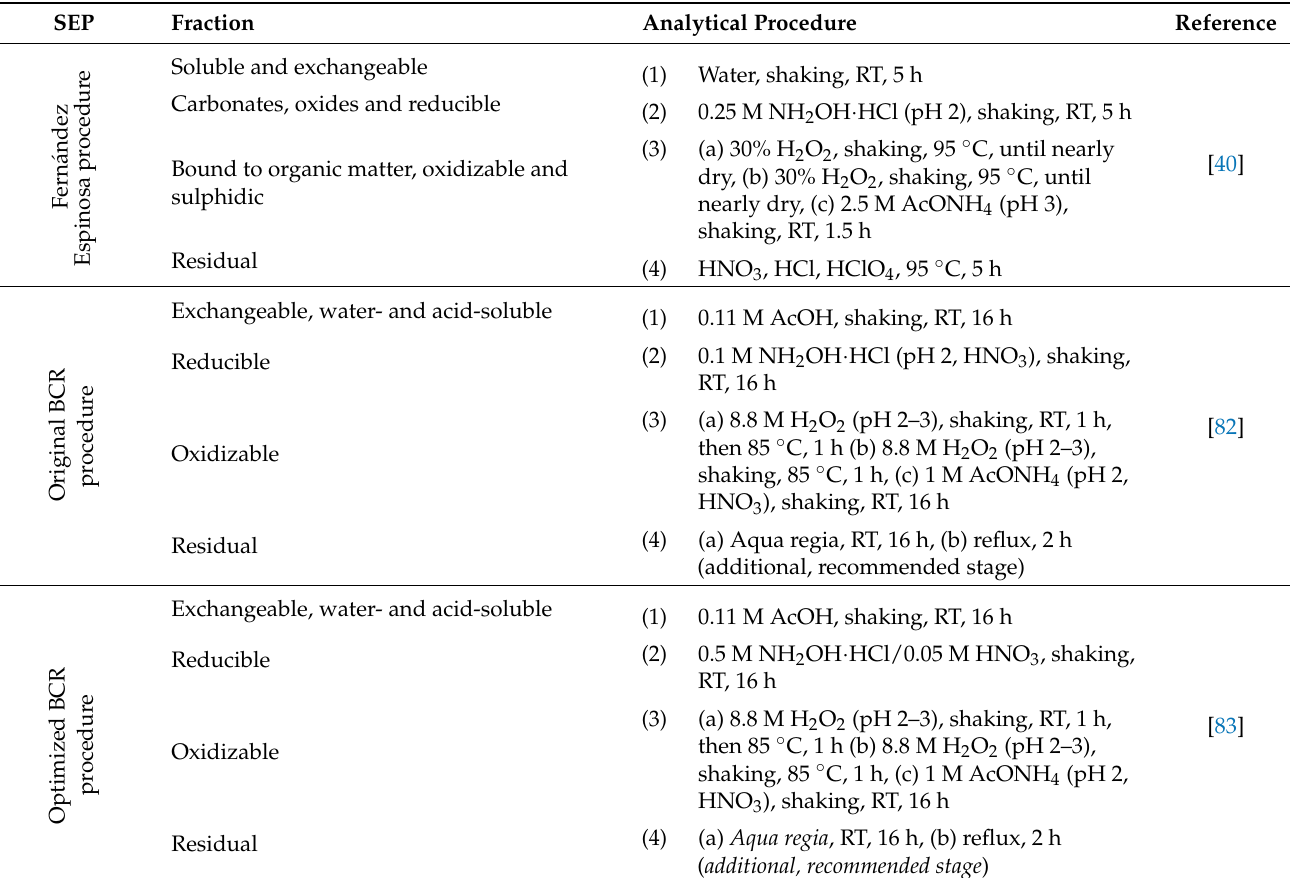
Table 1. Most widely used original procedures for chemical fractionation of PTEs in atmospheric particulate matter.